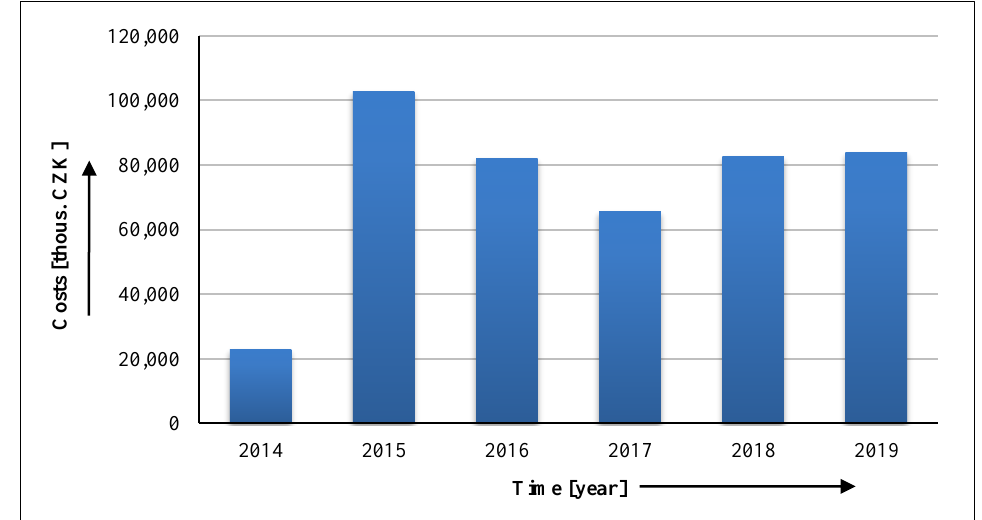
Figure 4. Development of PCR expenditures regarding Vrbětice emergency in 2014–2019 Zlín Region and Vlachovice